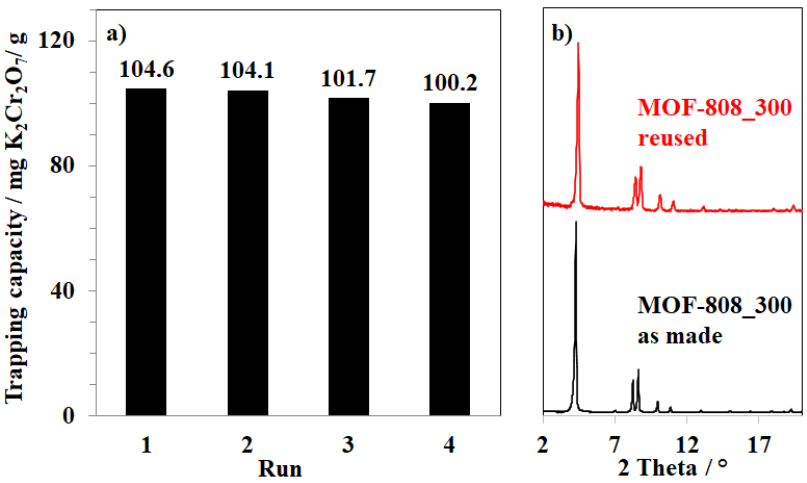
Figure 14. ( a ) Recycling test and ( b ) PXRD results of as made MOF-808_300 and MOF-808_300 after the fourth runs.